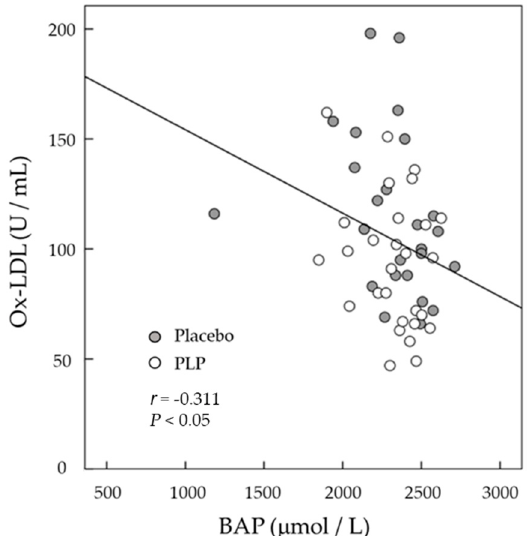
Figure 3. Scatter plots of the relationship between serum-oxidized low-density lipoprotein (Ox-LDL) and biological antioxidant potential (BAP) levels at 6 months. ( ○ ), placebo group; ( ● ) perilla leaf powder (PLP) intervention group.